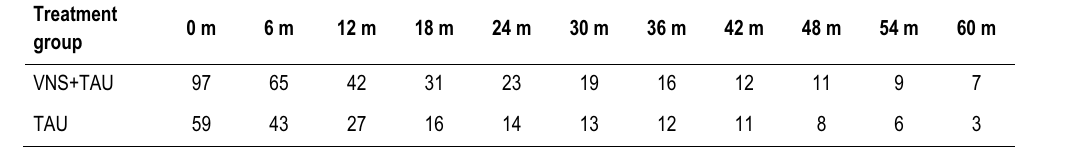
Fig. 1 Kaplan–Meier plot for time‑to‑initial response based on MADRS